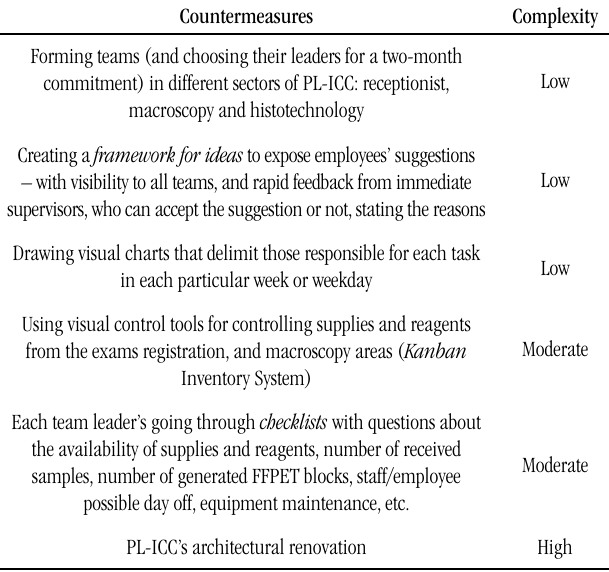
taBLE 2 – Adopted countermeasures, pointed in the first A3 report for the PL-ICC Lean philosophy implementation